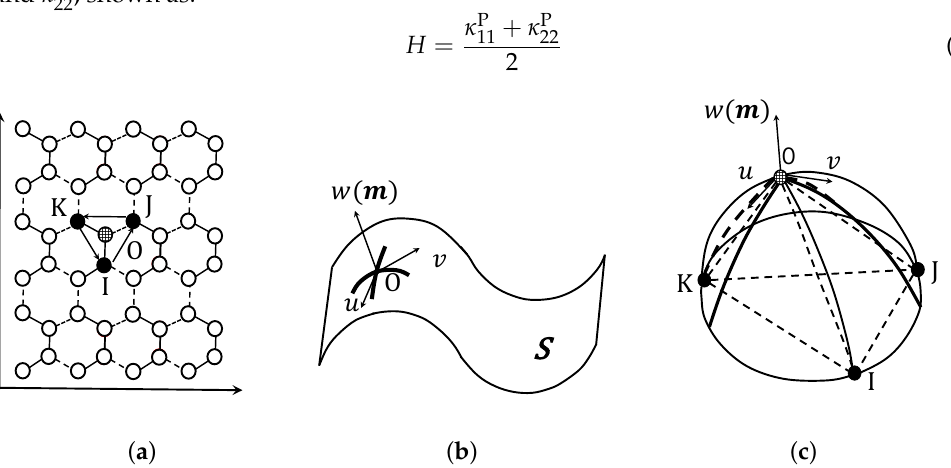
Figure 2. Schematic diagram of mean curvature defined by atomic configuration. ( a ) Discrete lattice structure. ( b ) The approximation of a continuous surface. ( c ) Curvature